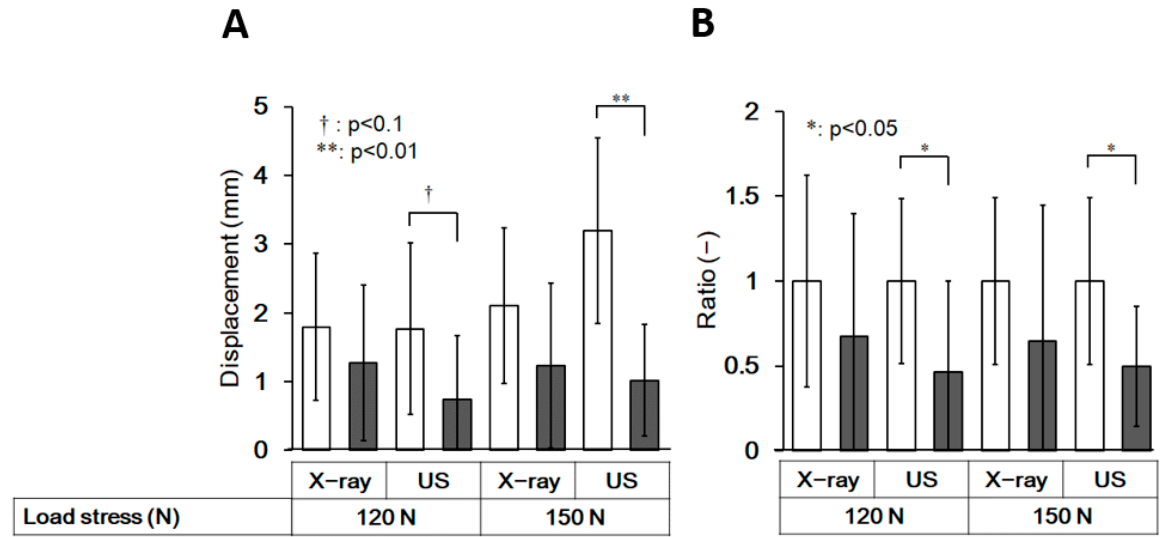
Figure 7. Comparison of the anterior displacement of the talus between the control and HAS groups. The amount of anterior talar displacement ( A ) and the ratio ( B ) compared to the control of each group, measured from stress X-ray and stress ultrasound images (US) in the control group and HAS group at 120 N and 150 N. There were eight subjects in the control group (16 ankles) and five subjects in the HAS group (8 ankles). The open column represents the control group and the closed column represents the HAS group. Error bars represent standard deviation values. The p -values were determined using a t-test. HAS, history of ankle sprain; US, ultrasound.